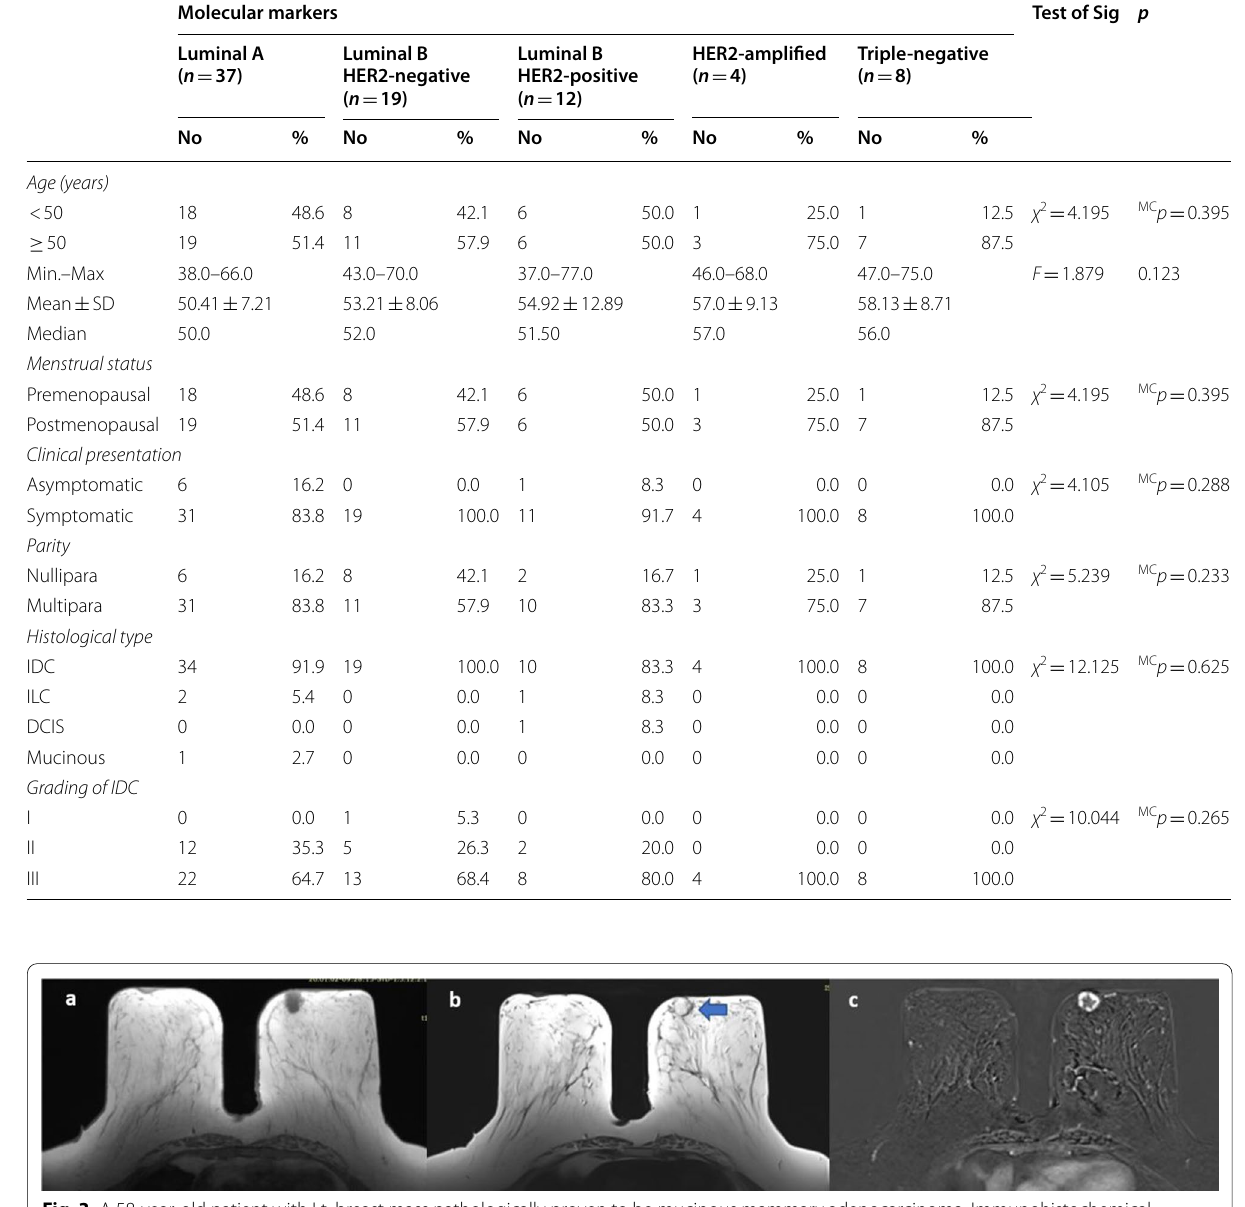
Fig. 3 A 58‑year‑old patient with Lt. breast mass pathologically proven to be mucinous mammary adenocarcinoma. Immunohistochemical markers in keeping with luminal A type. ITGB Fc 0.05 a MRI TIWIs hypo‑intense rounded mass lesion with circumscribed margin. Itmeasures = 2.1 2 cm. b in T2 WIs the lesion displays hyperintense signal (arrow). c T1 fat‑suppression post‑contrast subtracted image displays a left mass × lesion with ring enhancement. Normal MRI appearance of the right